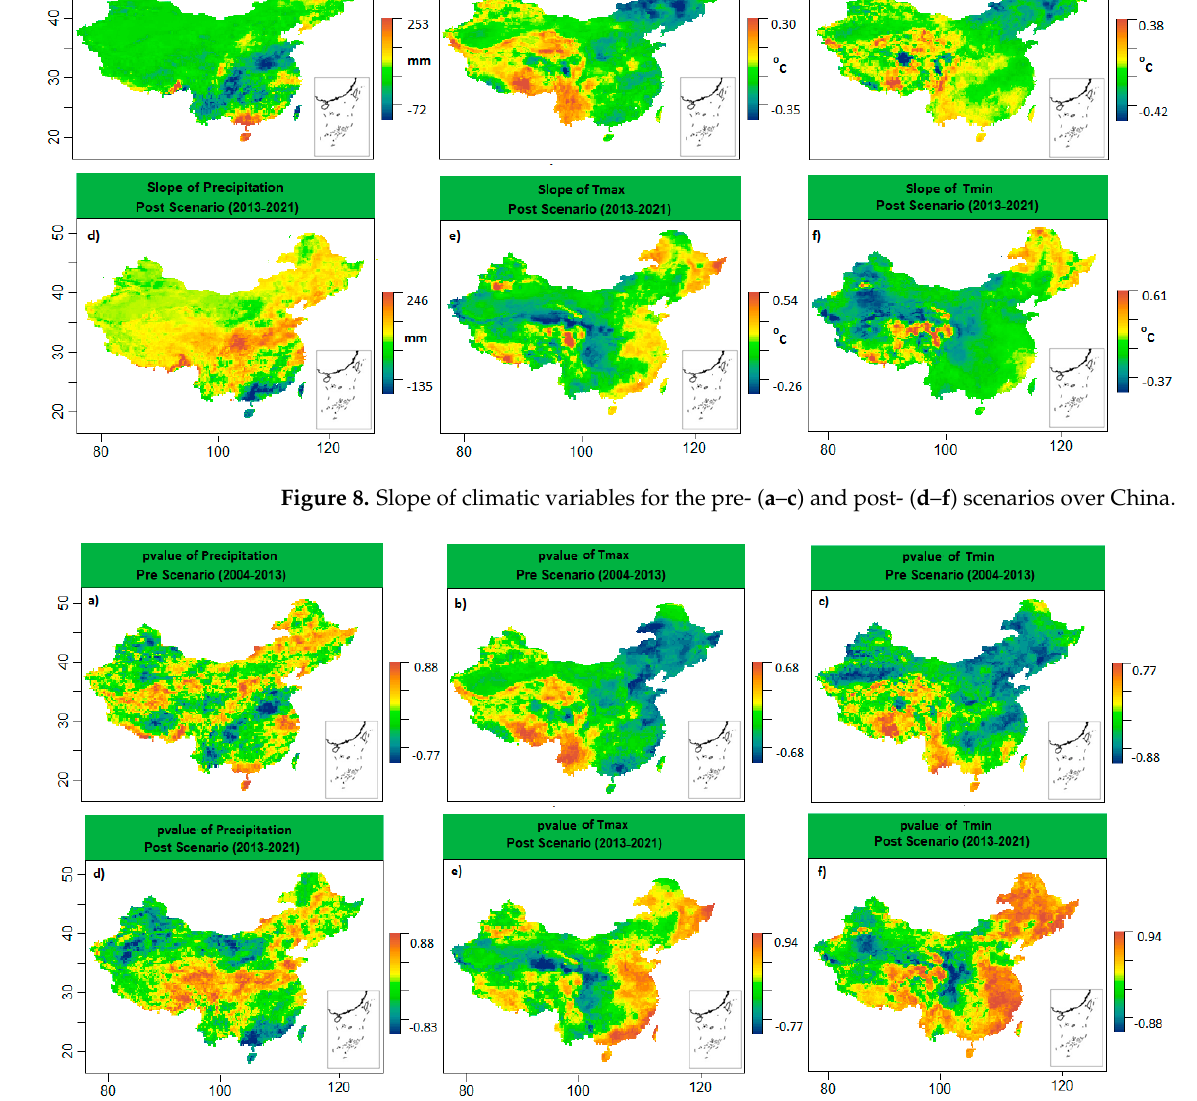
Figure 9. p value of climatic variables for pre- ( a , b , c ) and post- ( d , e,f ) scenarios over China. Note: Mann Kendall p value at 95% con fi dence ( p < 0.05).